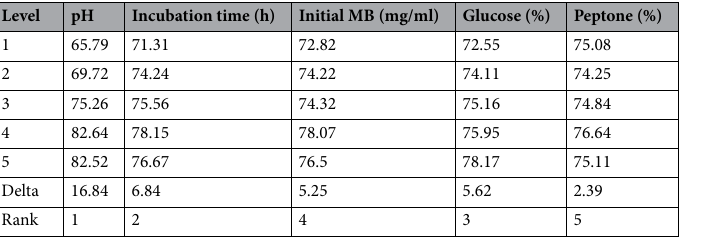
Table 5. Mean response analysis of Taguchi data for detection of the important factors and their levels for maximization of MB biosorption by the viable cells of P. alcaliphila NEWG-2 .